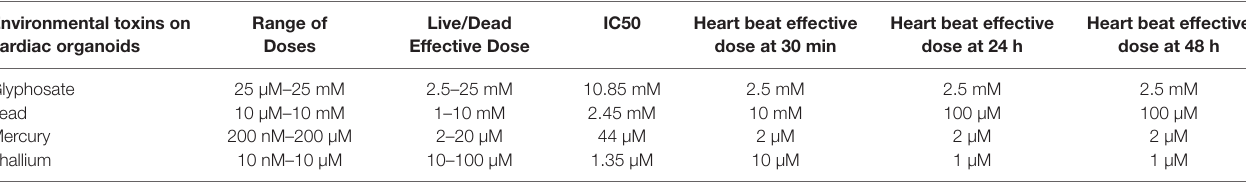
TaBle 2 | Summary of the effects of the environmental toxins on cardiac spheroids. environmental toxins on cardiac organoids